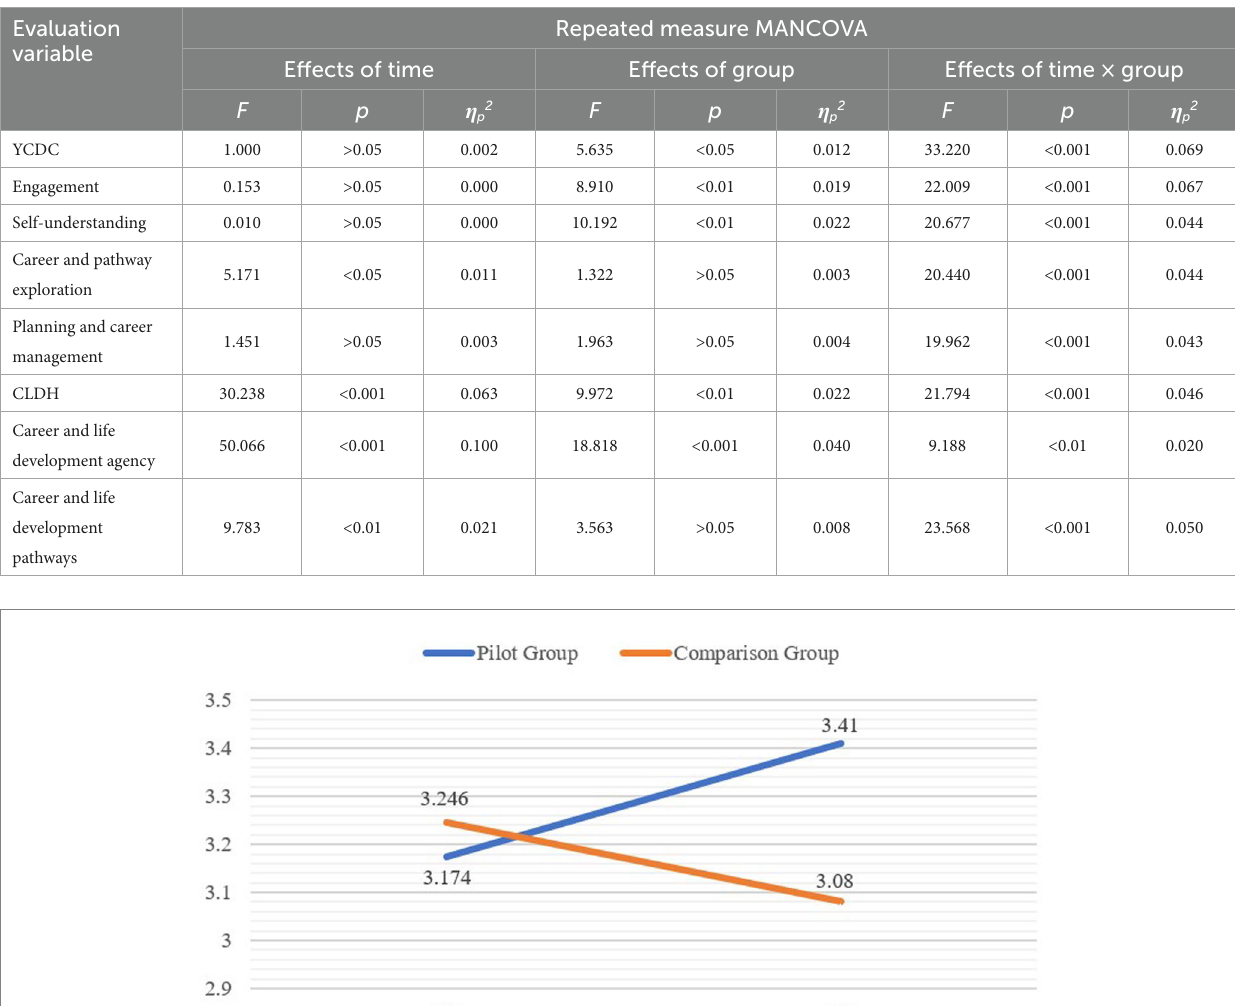
TABLE 5 Results of the repeated-measures MANCOVA.